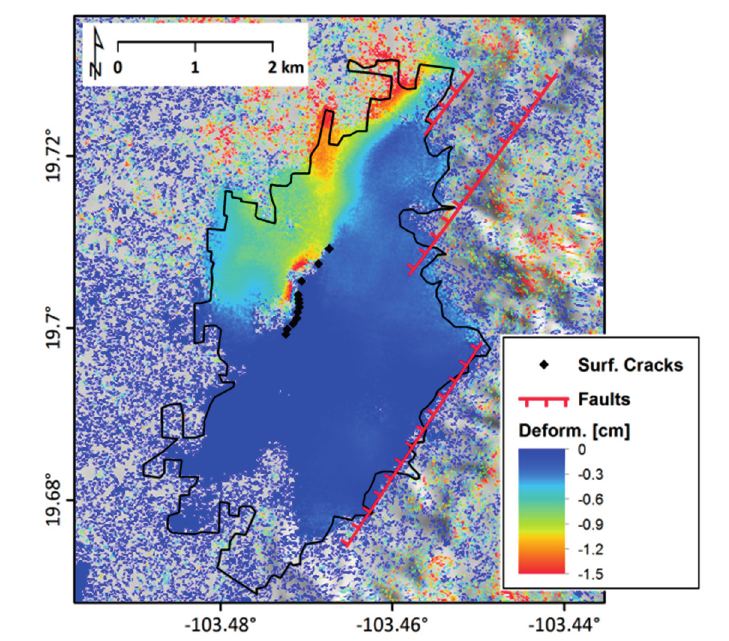
Figure 9. Co-event deformation by means of DInSAR applied to RADARSAT-2 data (6 September–11 December 2012). The maximum measured deformation in LOS is about 1.5 cm, located close to the surface ruptures and in the northern area of CG. The loss of coherence, visible in proximity of the fissures, can be due to a large